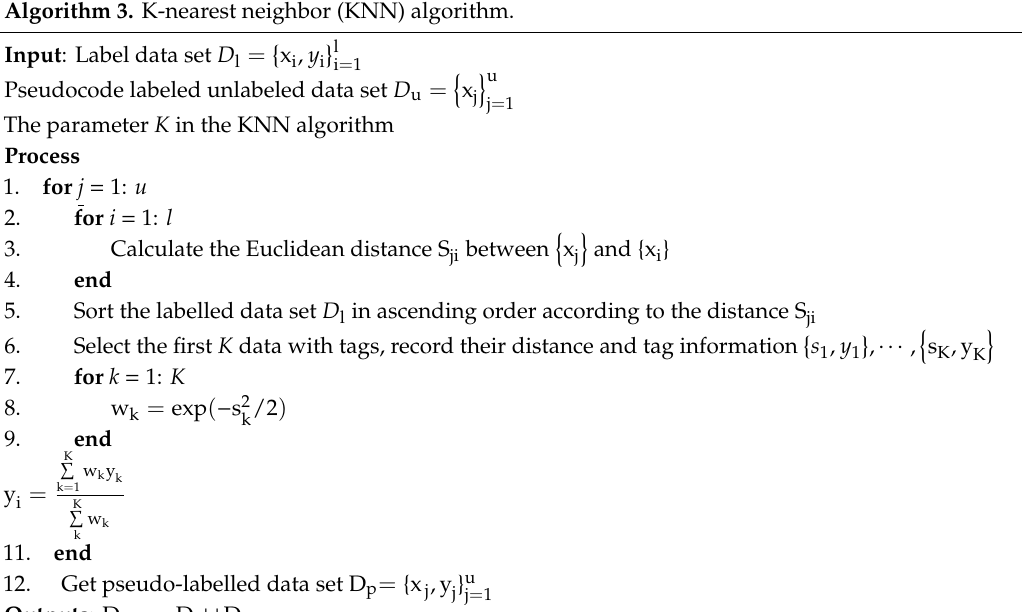
Algorithm 3. K-nearest neighbor (KNN)